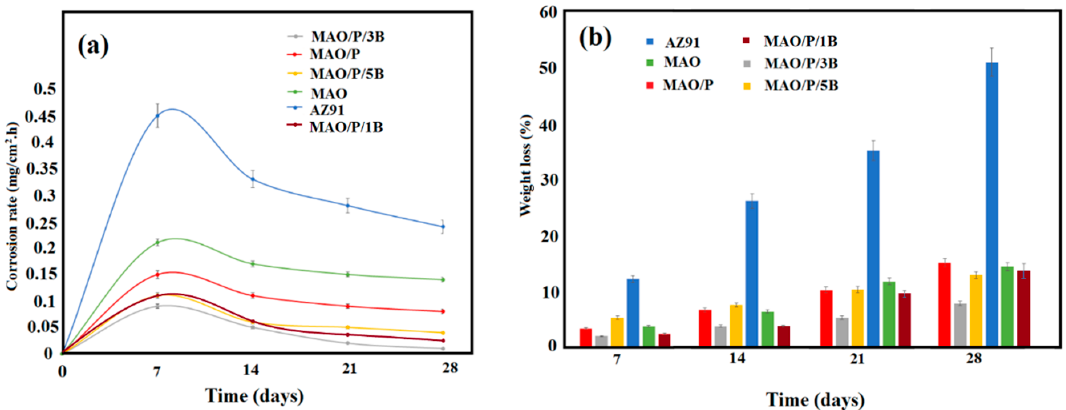
Figure 5. ( a ) Corrosion rate and ( b ) weight loss of samples after different soaking times in PBS.